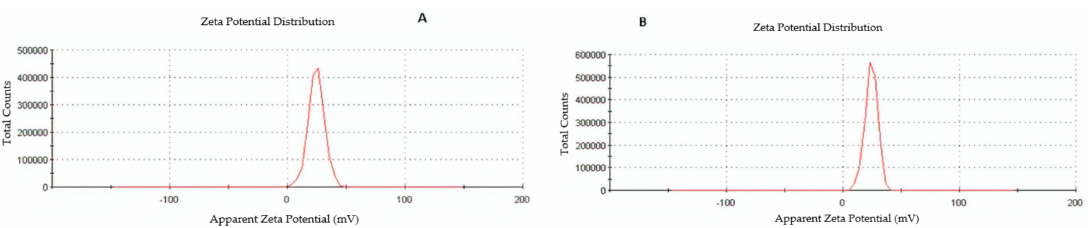
Figure 3. Photon correlation spectroscopy (PCS) images of ( A ) placebo chitosan nanoparticles and ( B ) rotigotine-loaded chitosan nanoparticles.